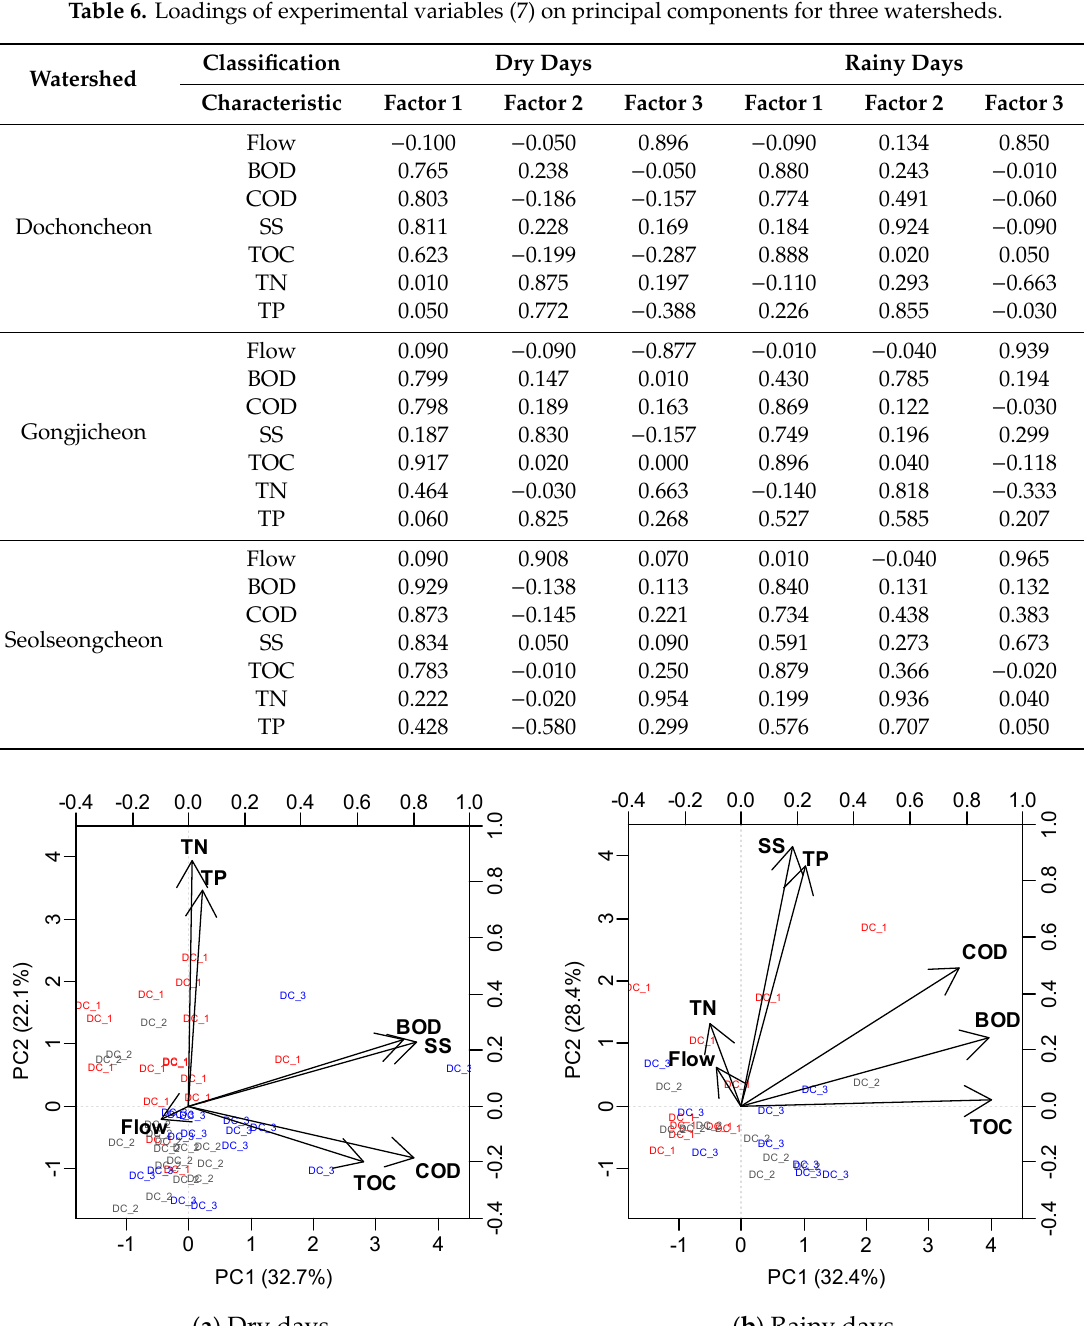
( b ) Rainy days Figure 9. Biplot of principle components for water quality characteristics in Gongjicheon.